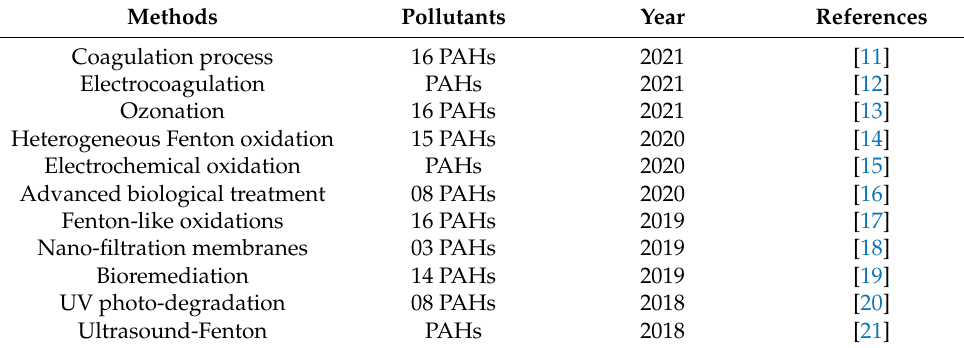
Table 1. Treatment methods used for PAH